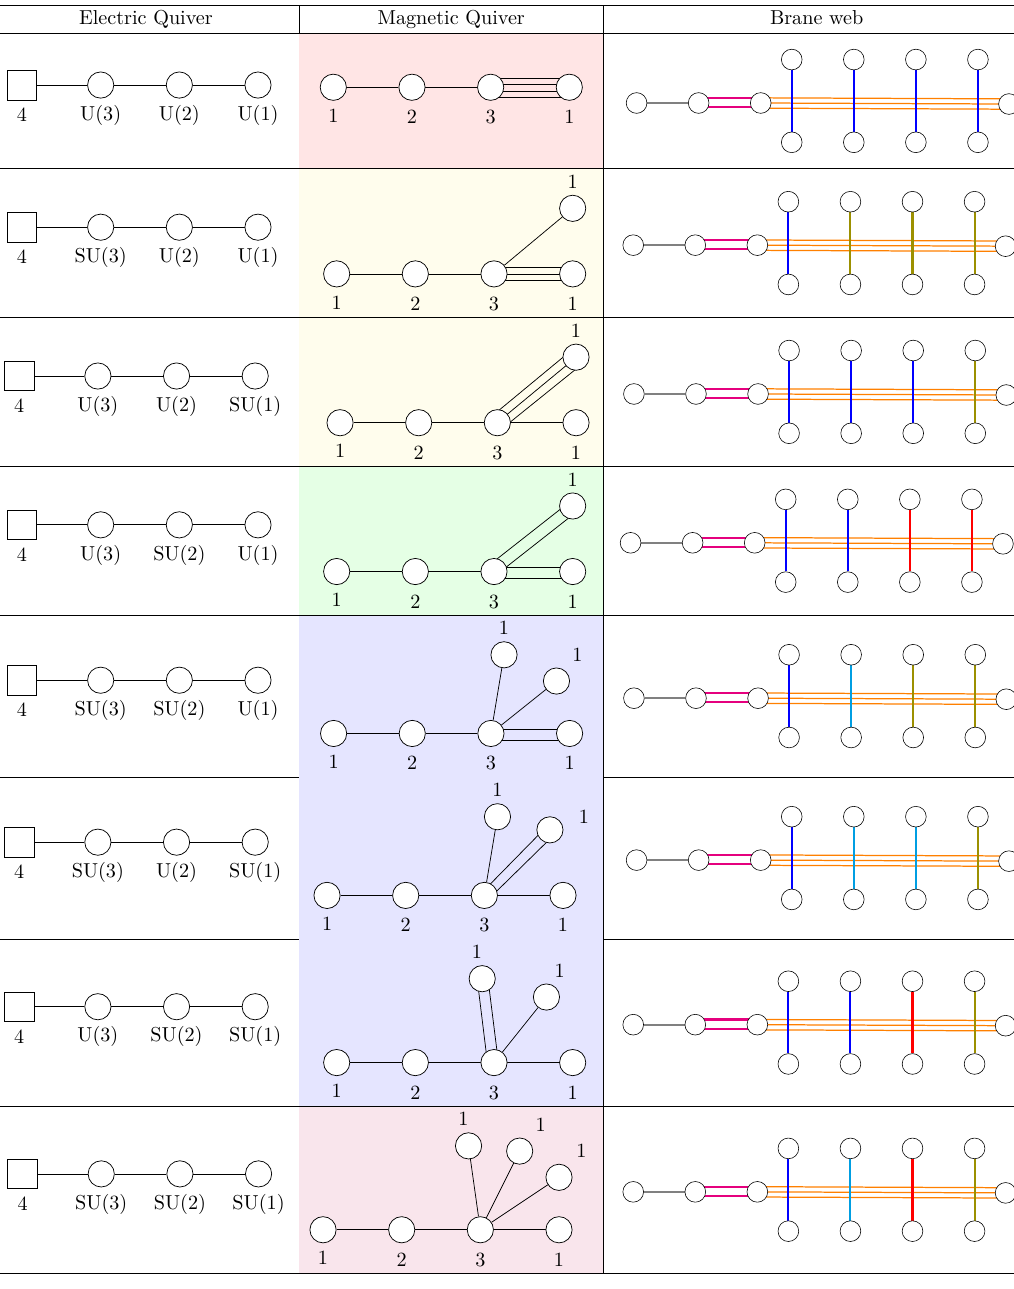
Table 2 . The left column shows extensions of the T (SU(4)) quiver with different combinations of U/SU nodes. The middle column shows their respective magnetic quivers, which in this particular case are in fact 3d mirrors. These magnetic quivers are derived from 5d brane webs, which yield quivers with all unitary gauge nodes. The right column shows the maximal decompositions of the brane webs into subwebs, with the necessary locking imposed. Note that the two magnetic quivers in blue cells and the three magnetic quivers in yellow cells are identical: this shows that Higgs branches for the family of theories considered in this table depends only on partitions of 4 . This is reflected in the next three tables by merging the corresponding